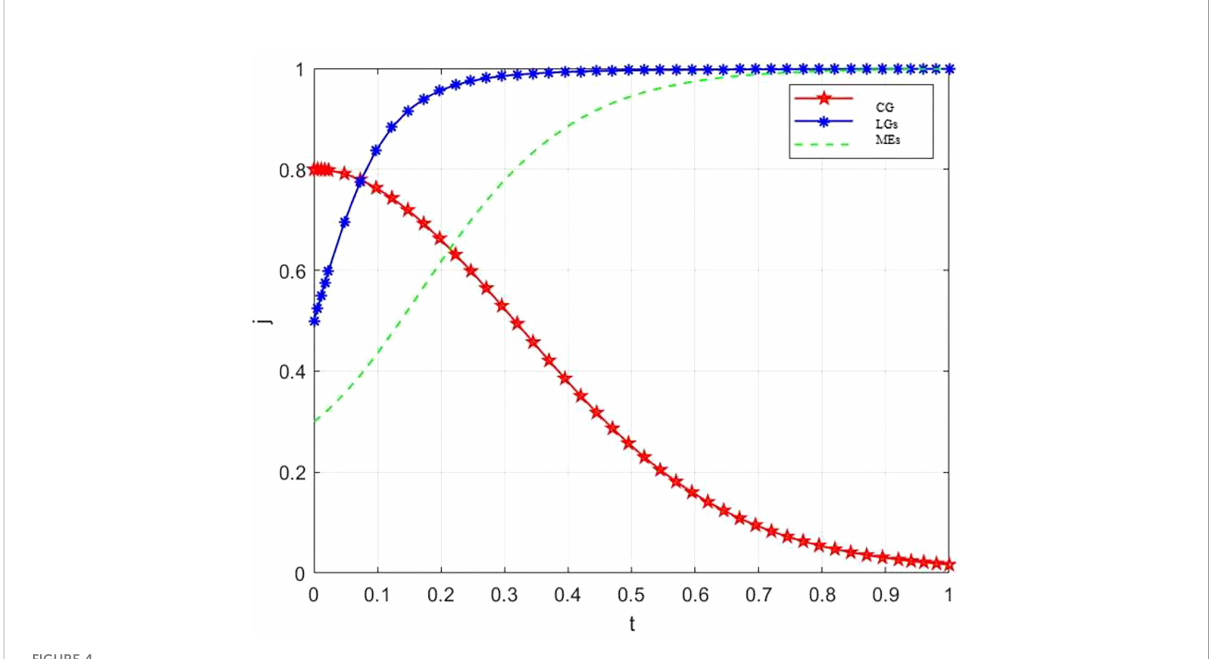
FIGURE 4 Three-way evolution with initial